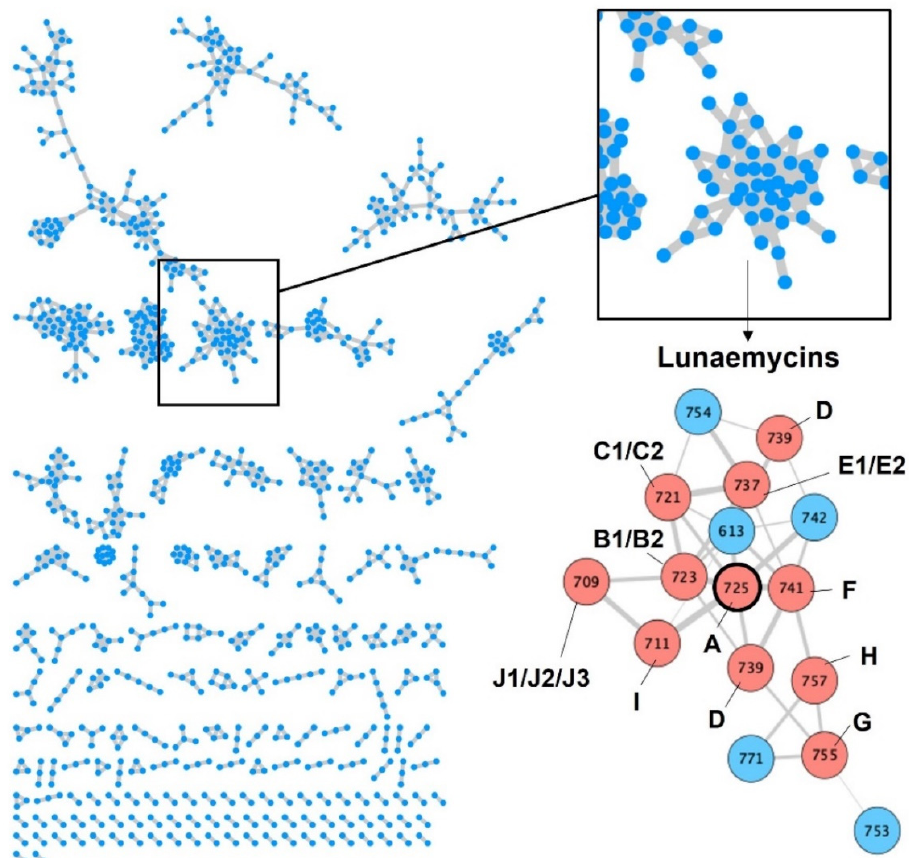
Figure 6. GNPS of metabolites extracted from S. lunaelactis strains. Left panel: Constellations of compounds constructed based on GNPS processing the UPLC-MS/MS data obtained from the full extract of the eleven S . lunaelactis strains grown on ISP7 medium. Each node in a constellation represents a parent mass (MS1) of a compound detected in one or more of the eleven full extracts analyzed. Right panel: Constellation of lunaemycins where nodes are linked by a straight line when they share similar fragmentation patterns. Pink and blue nodes: lunaemycins with solved and unsolved structure, respectively (see details in Table 3, Figure 7, and Supplementary Figures S7–S20).